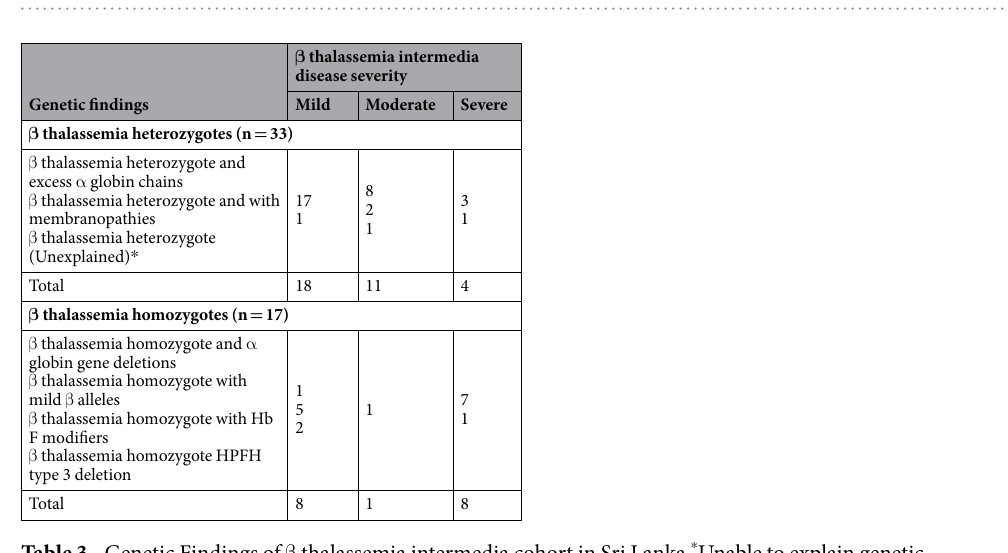
Table 2. Laboratory Findings of β thalassemia intermedia cohort in Sri Lanka. Data are median (IQR) or number (%).